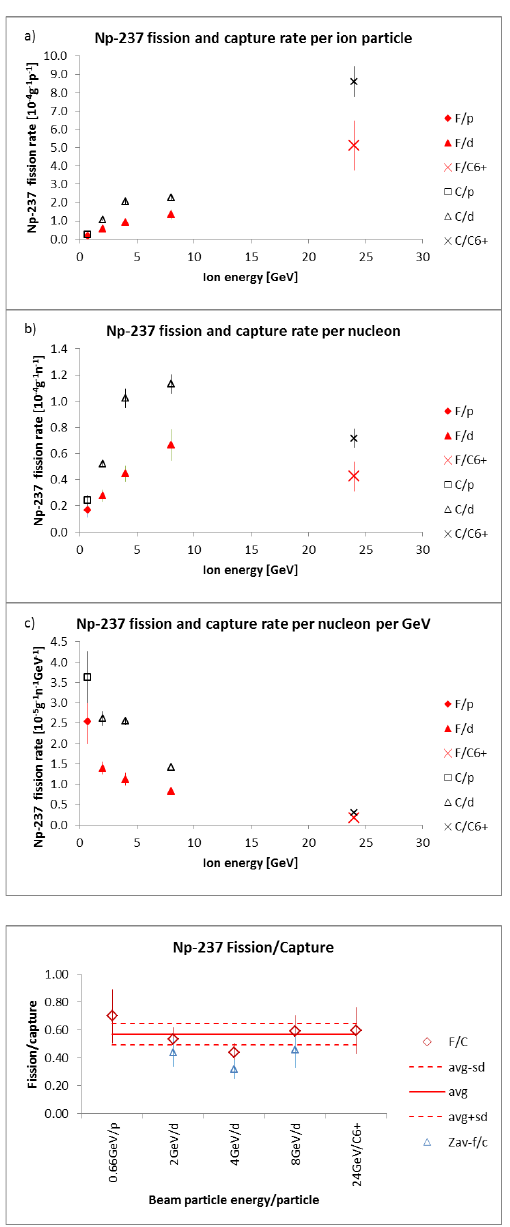
Figure 5. Np-237 fission-to-capture ratio for each experiment for samples located in the left side window